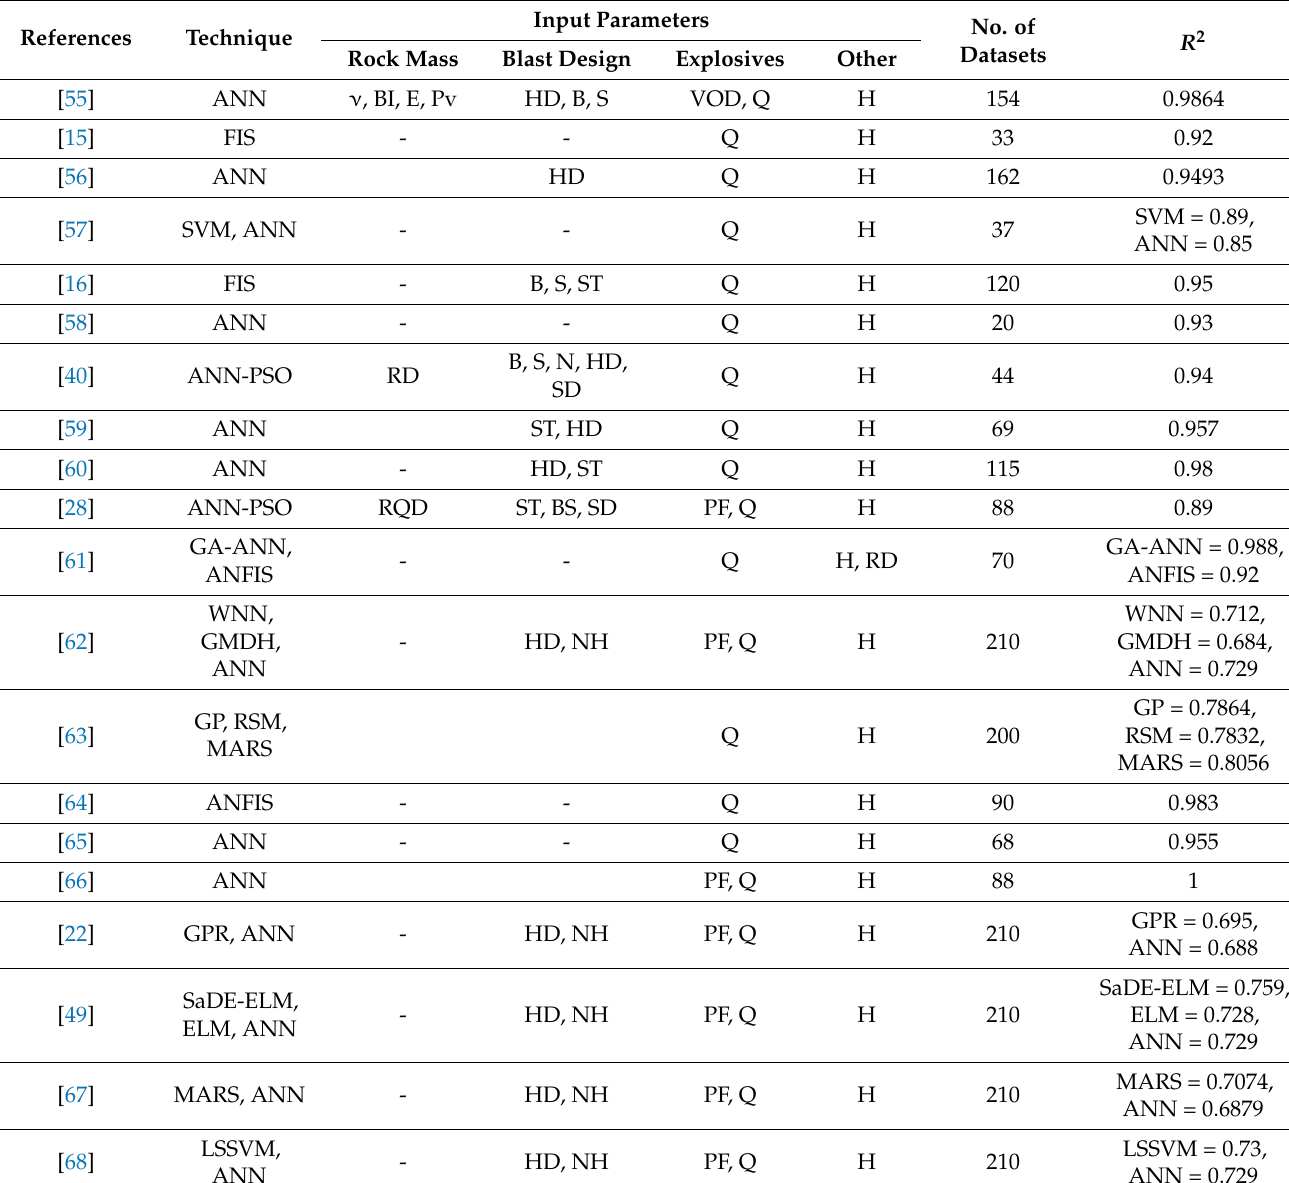
Table 3. Input parameters, size of data and AI techniques for prediction of ground